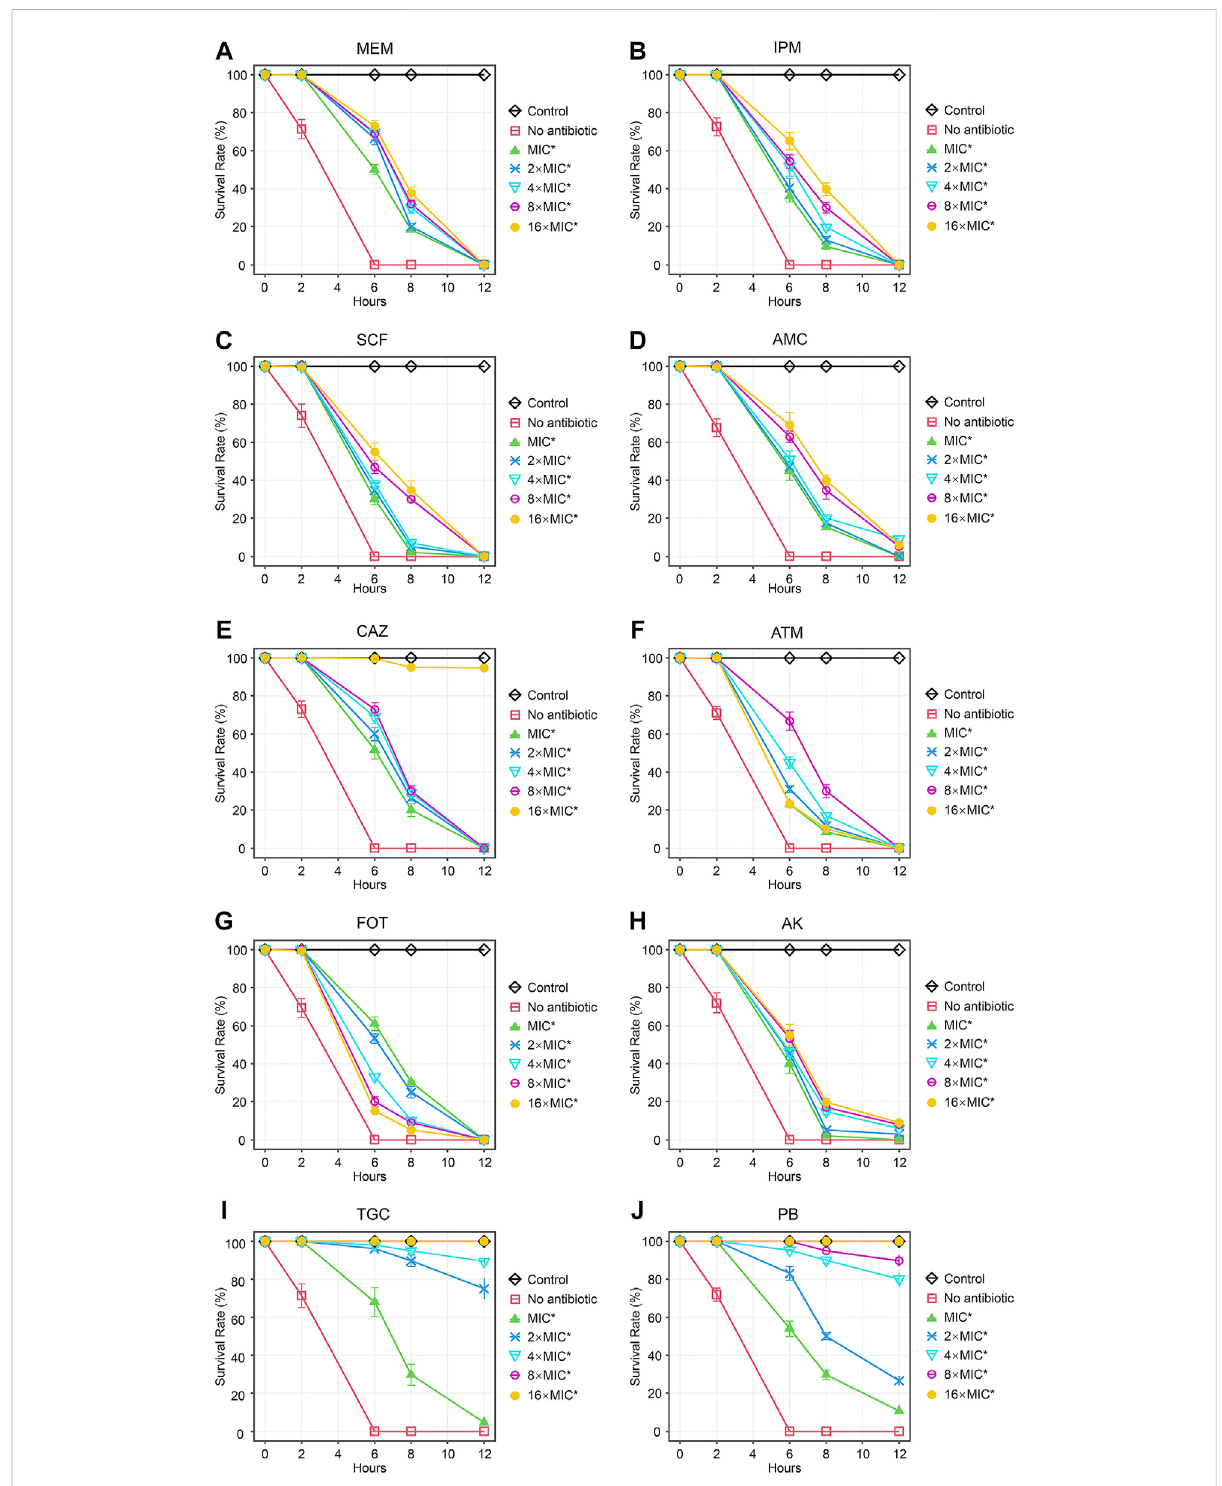
FIGURE 2 Time curve analyses of the protective ef fi cacy of different concentrations of antibiotics in CRKP-infected C. elegans. Time curves were used to evaluate the time-dependent changes in the survival of CRKP-infected C. elegans treated with different concentrations of (A) MEM, (B) IPM, (C) SCF, (D) AMC, (E) , CAZ, (F) ATM, (G) FOT, (H) AK, (I) TGC, and (J) PB. Results are expressed as mean ± SD. Asterisks represent the signi fi cance of the difference in survival between the antibiotic-treated group and no antibiotic group ( p <